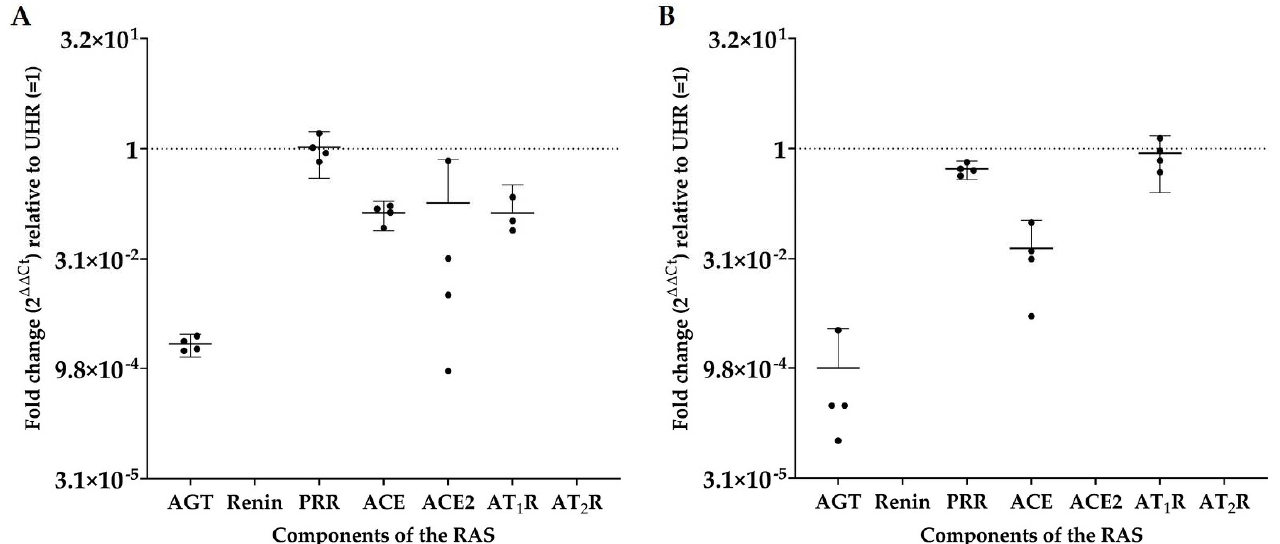
Figure 6. Fold-change (2 ∆∆ Ct ) in transcript expression of components of the renin-angiotensin system (RAS): angiotensinogen (AGT), renin, PRR, ACE, ACE2, AT 1 R, and AT 2 R, as determined by RT-qPCR in four metastatic head and neck cutaneous squamous cell carcinoma (mHNcSCC) tissue samples ( A ) and four mHNcSCC-derived primary cell lines ( B ). CT values were normalized to the reference genes GAPDH and PUM1 to calculate ∆ CT, and expression compared to that of UHR (y = 1). Error bars represent 95% confidence intervals of the mean. Graphs are shown with log2 scale.